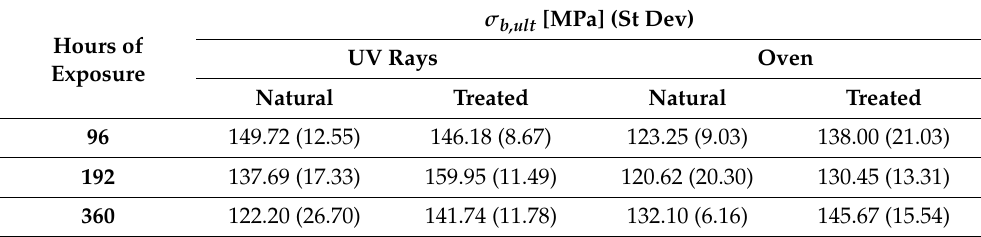
Figure 8. Effect on bending strength of the exposure to the temperature of 40 °C compared to the exposure to UV rays. ( a ) Natural case; ( b ) Treated case. Table 2. Difference in bending strength between samples exposed to UV rays and those exposed to temperature for three different lengths of exposure.